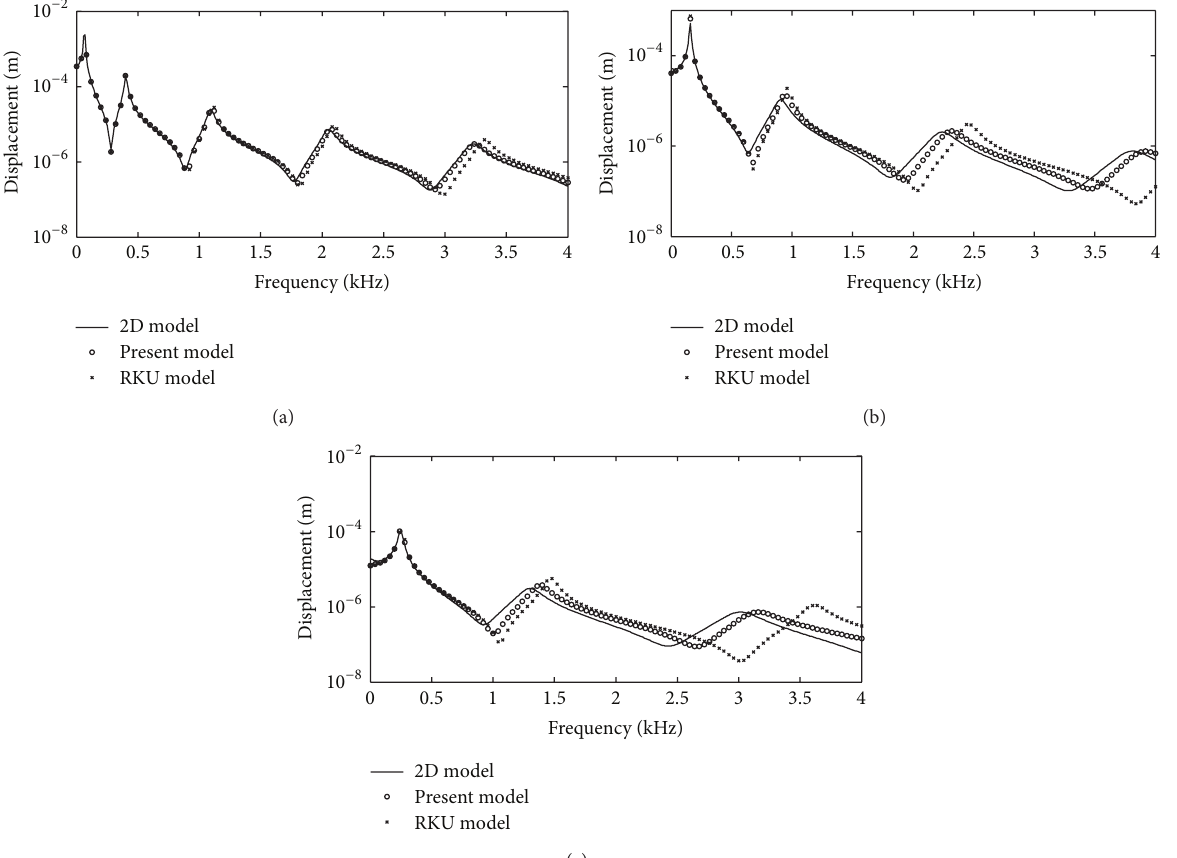
3.3. Analysis of the Frequency Response Function. The